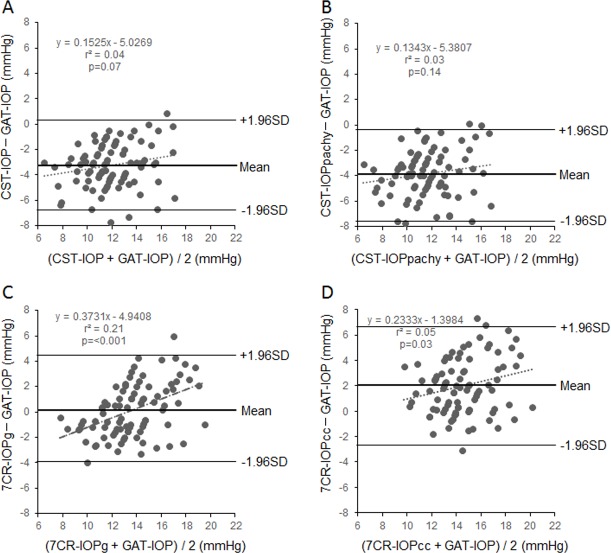
Bland-Altman plots for inter-method differences.A, The differences between the CST-IOP and GAT-IOP. B, The difference between the CST-IOPpachy and GAT-IOP. C, The difference between the 7CR-IOPg and GAT-IOP. D, The difference between the 7CR-IOPcc and GAT-IOP. The mean values and 95% LOA are indicated by bold lines and solid lines, respectively. IOP, intraocular pressure; CST-IOP, IOP using the Corvis ST; CST-IOPpachy, corrected CST-IOP; GAT-IOP, IOP using the Goldmann applanation tonometer; 7CR-IOPg, Goldmann-correlated IOP using the 7CR tonometer; 7CR-IOPcc, corneal-compensated IOP using the 7CR tonometer; CI, confidence interval; LOA, limits of agreement.